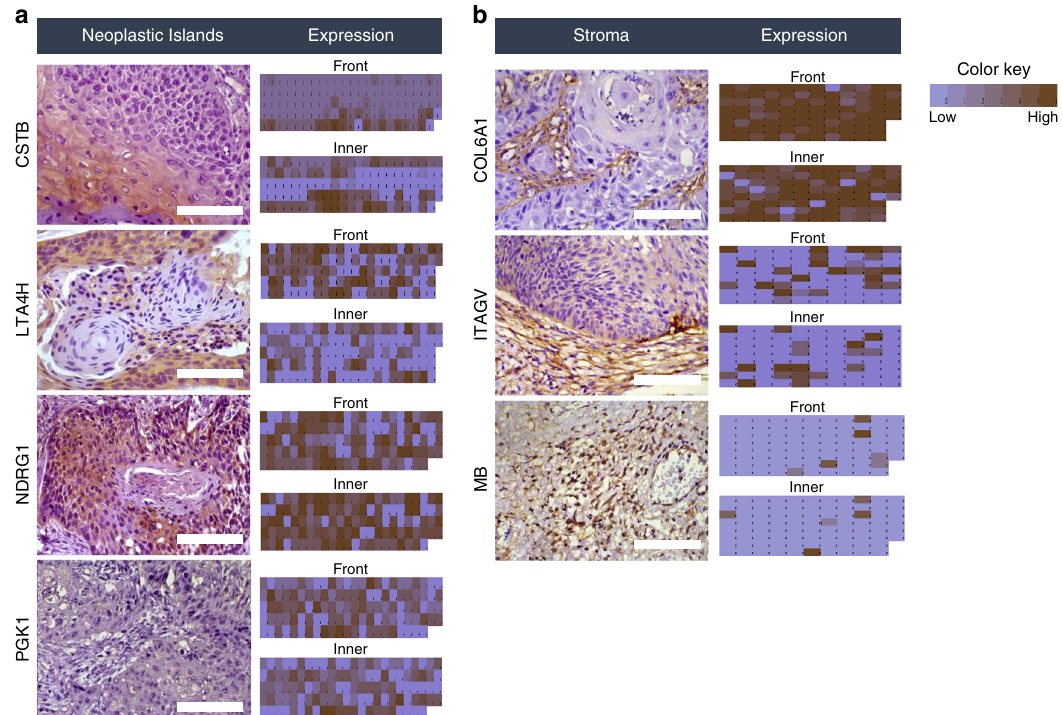
Fig. 4 Immunohistochemical staining of targeted proteins. Oral SCC tissue samples from a set of 125 cases were used to verify the abundance of a CSTB, LTA4H, NDRG1, and PGK1 neoplastic island proteins, and 96 cases were used to verify the abundance of b COL6A1, ITGAV, and MB tumor stroma proteins. Among the cases, it was possible to analyze 114 cases for CSTB, 118 cases for LTA4H, 119 cases for NDRG1, 118 cases for PGK1, 93 cases for COL6A1, 80 cases for ITGAV, and 86 cases for MB. The scores that represent the sum of the intensities and percentage of protein staining in the ITF or the inner tumor are shown as a heat map. Differential staining in ITF and inner tumor in both neoplastic islands and tumor stroma was identi fi ed, in agreement with the MS discovery analysis however, we also identi fi ed negative cases for each protein and cases with gradual staining according to the color key shown at the top right. For proteins selected in neoplastic island, increased CSTB and NDRG1 expression was identi fi ed in the inner tumor, according to the MS results, with staining only inside neoplastic cells of OSCC. However, LTA4H and PGK1 presented peripheral staining in neoplastic cells and were also detected in cells from tumor stroma, such as in fl ammatory cells. For proteins selected in tumor stroma, greater COL6A1 and MB expression was identi fi ed in the ITF area, which demonstrates the preferential localization in OSCC regions compared with that observed in the MS discovery analysis. COL6A1, ITGAV, and MB proteins were preferentially present in tumor stroma (Histological images obtained using a ×40 objective, scale bars, 200 μ